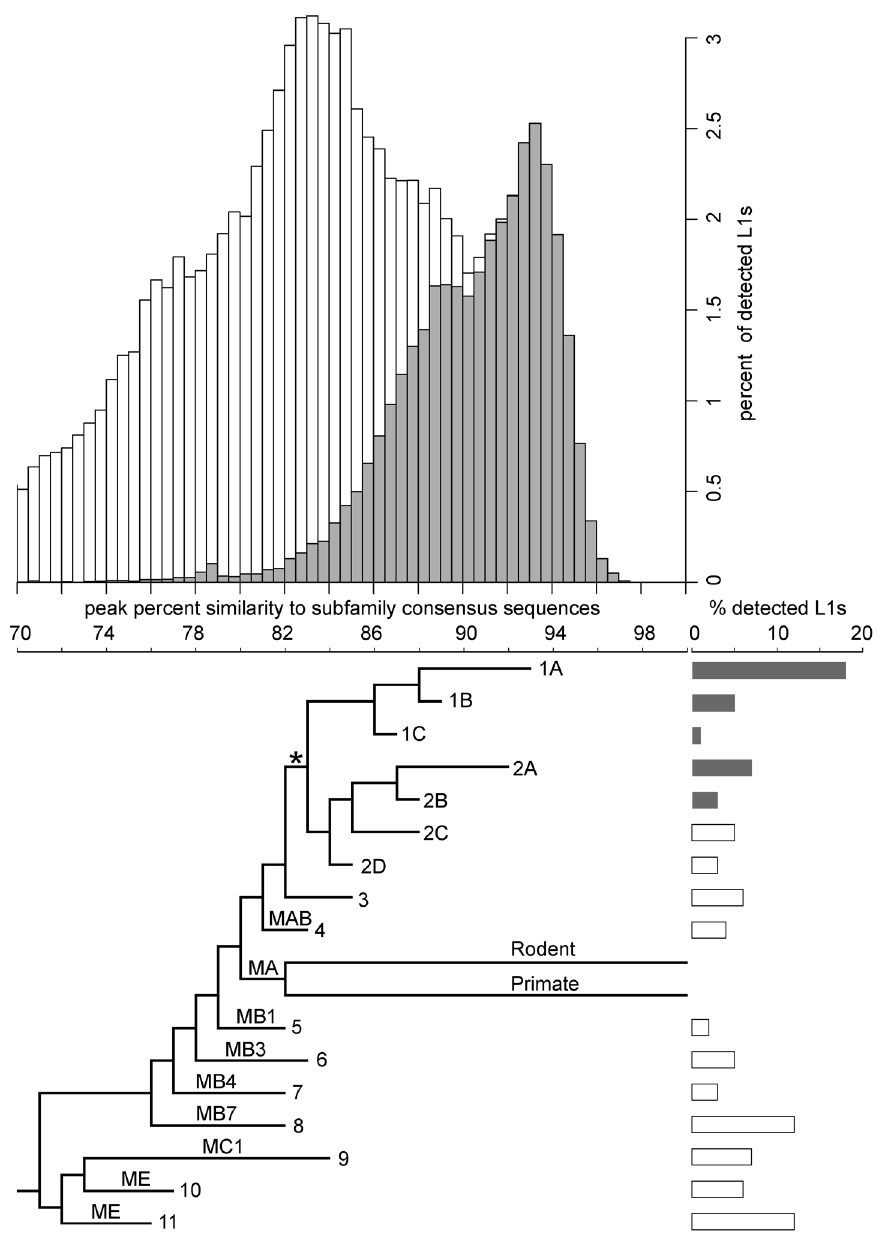
Figure 1. Age distribution and phylogeny of L1s in the megabat genome. The histogram shows the age distribution of megabat L1s as percent of the total 79,978 L1s detected in the megabat genome. Grey bars indicate L1s that are bat-specific. Age of L1s is determined by their percent identity to the corresponding subfamily consensus in 0.5% windows on the horizontal axis – the higher the percent identity, the younger the subfamily. The horizontal axis is shared with the phylogenetic tree which shows the evolutionary history of L1 families. Taxa names are the numbers assigned to megabat L1 families; names on branches are those given to ancestral mammalian L1 families by Smit et al. [58]. Divergence of the human- and rodent-specific L1s and their persistence to present time are indicated by labeled branches. The backbone of the tree is derived from the maximum likelihood tree of all megabat L1 subfamilies and ancestral mammalian L1 families shown in Figure S1, and the branch lengths of the tree were calibrated at the peak of retrotransposition of each family as described in Materials and Methods. * indicates the point after which bat-specific L1s (grey bars) diverged. Lengths of the bars to the right of each terminal branch indicate the percent of all detected L1s contributed by that family.